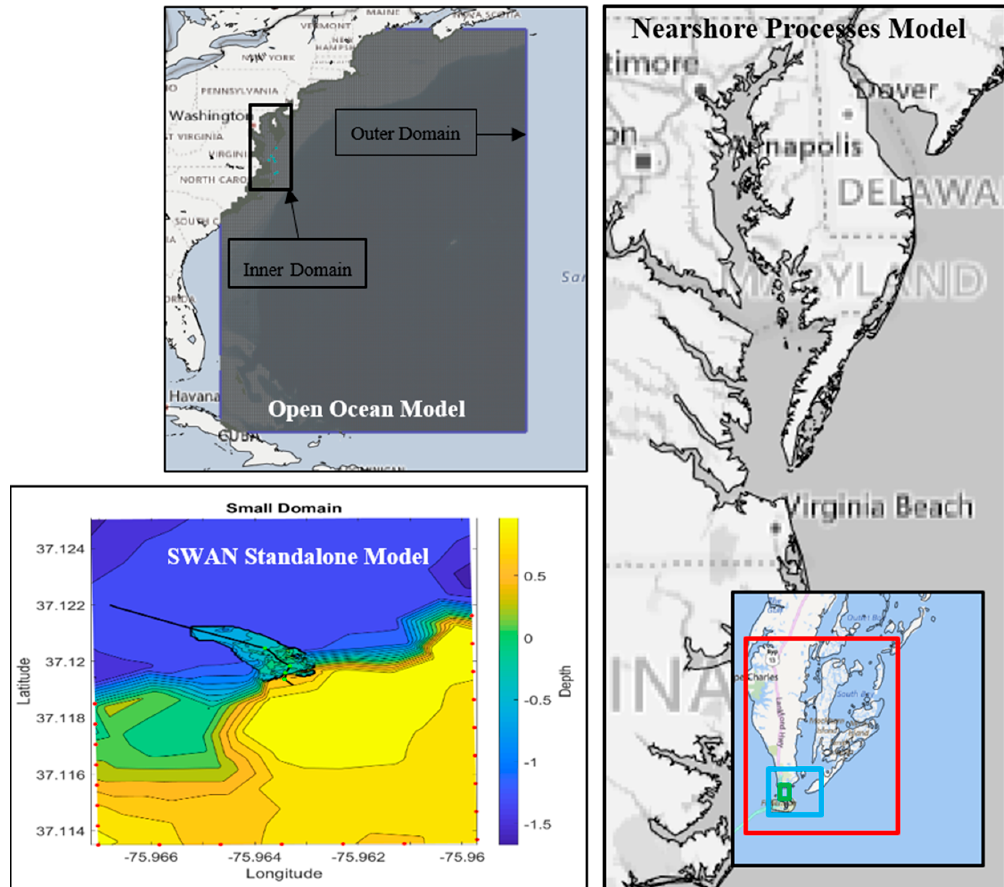
Figure 4. Placement of the three model domains with the open ocean model and its inner and outer domain in the top left, the Nearshore Processes Model with the finer domains outlined by rectangles on the right and the SWAN model on the bottom left. The SWAN model also depicts the points at which the boundaries were implemented as well as the transect on which the pressure gauge and vegetation surveys were conducted.